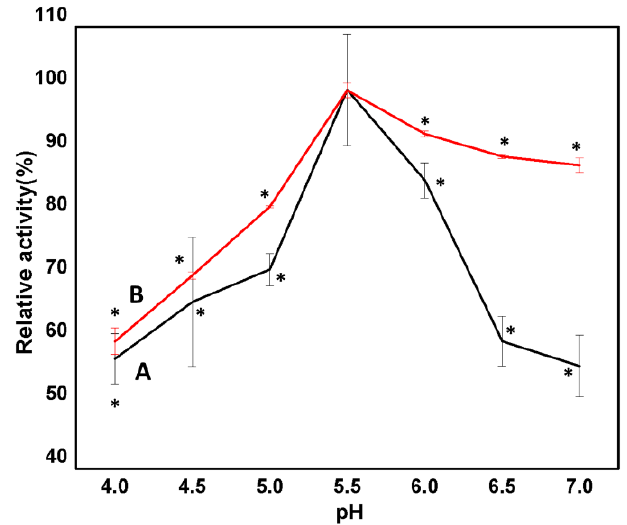
Figure 7. Effect of pH on the free and immobilized Man/Cel5B activity. ( A ) Free Man/Cel5B. The pH values showing significant ( p < 0.05) difference from optimum pH were marked with ‘*’. ( B ) Immobilized Man/Cel5B. The pH values showing significant ( p < 0.05) difference from optimum pH were marked with ‘*’.